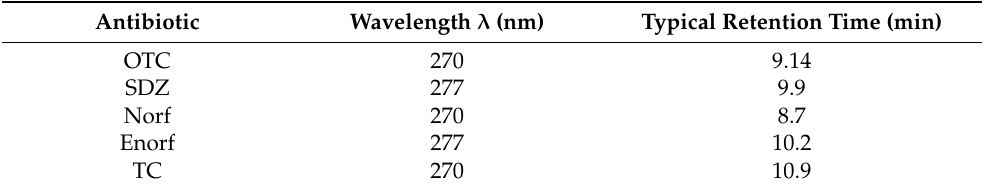
Table 1. The maximum UV-detection wavelengths and retention time of the five